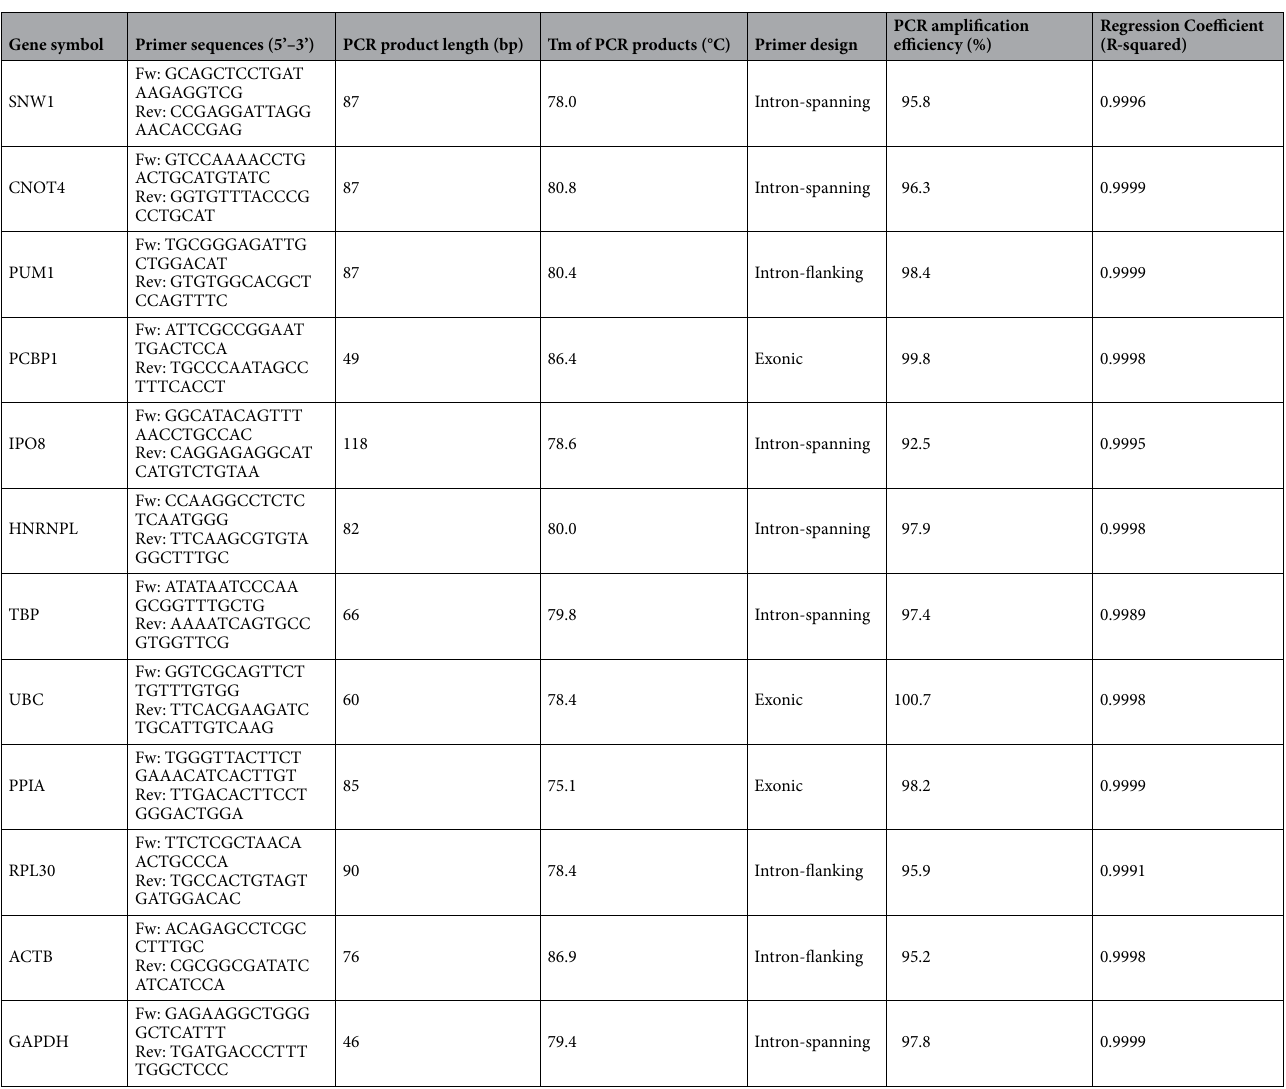
Table 3. List of candidate reference genes and the corresponding primer parameters used in this study. Regression coefficients were determined by performing least squares linear regression to the average Cq values of technical replicates. Base pairs,